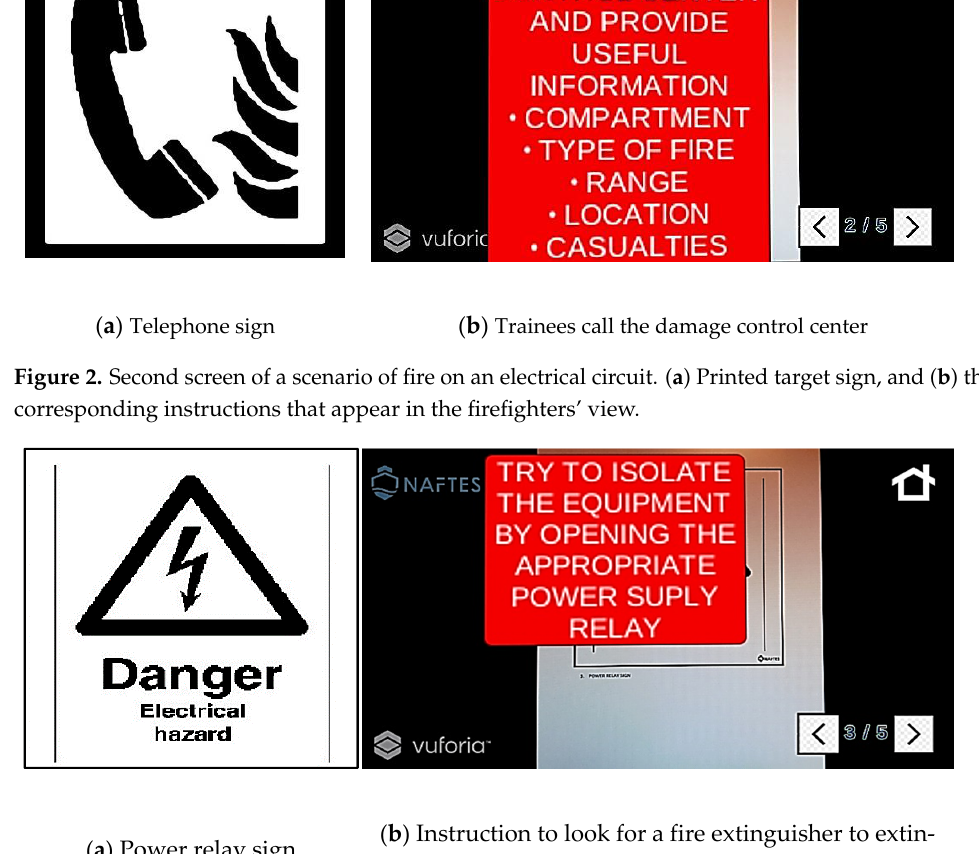
Figure 3. Third screen of a scenario of fire on an electrical circuit. ( a ) Printed target sign, and ( b ) the corresponding instructions that appear in the firefighters’ view.